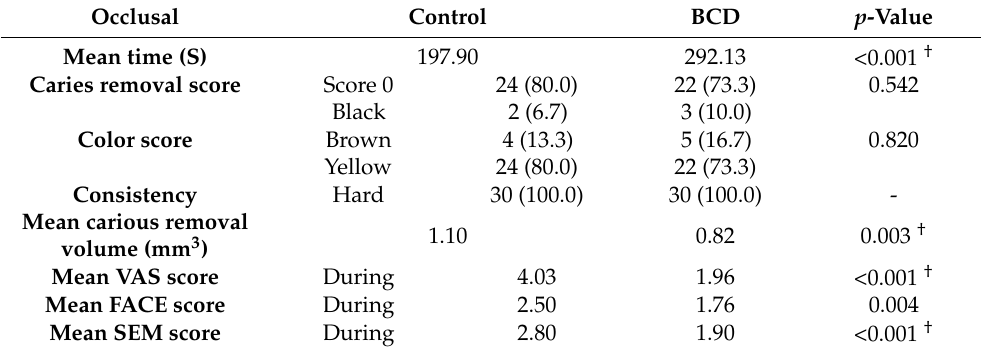
Table 1. Mean time, caries removal score, color score, consistency score, volume, mean VAS, FACE, and SEM at baseline, during procedure, after completion and at 24 h among the groups (Occlusal